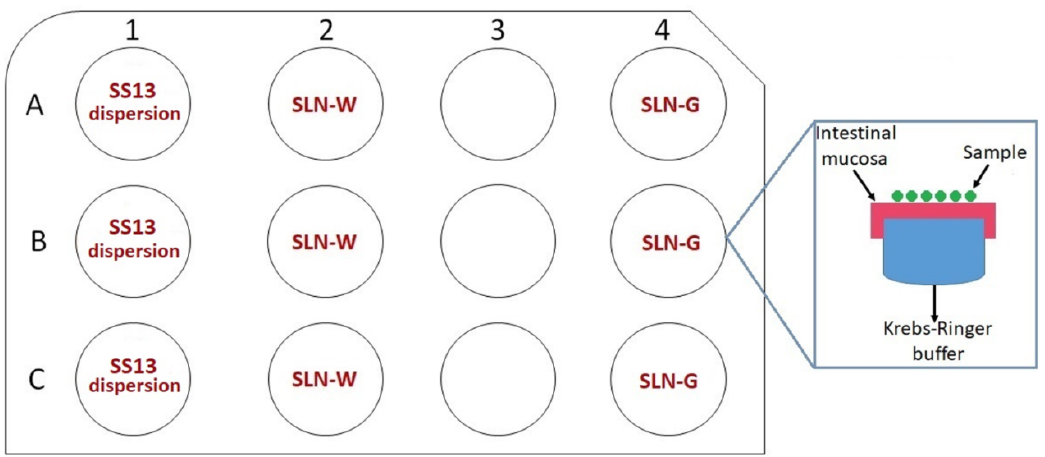
Figure 1. Schematic representation of plates used for ex vivo permeation test. The test was